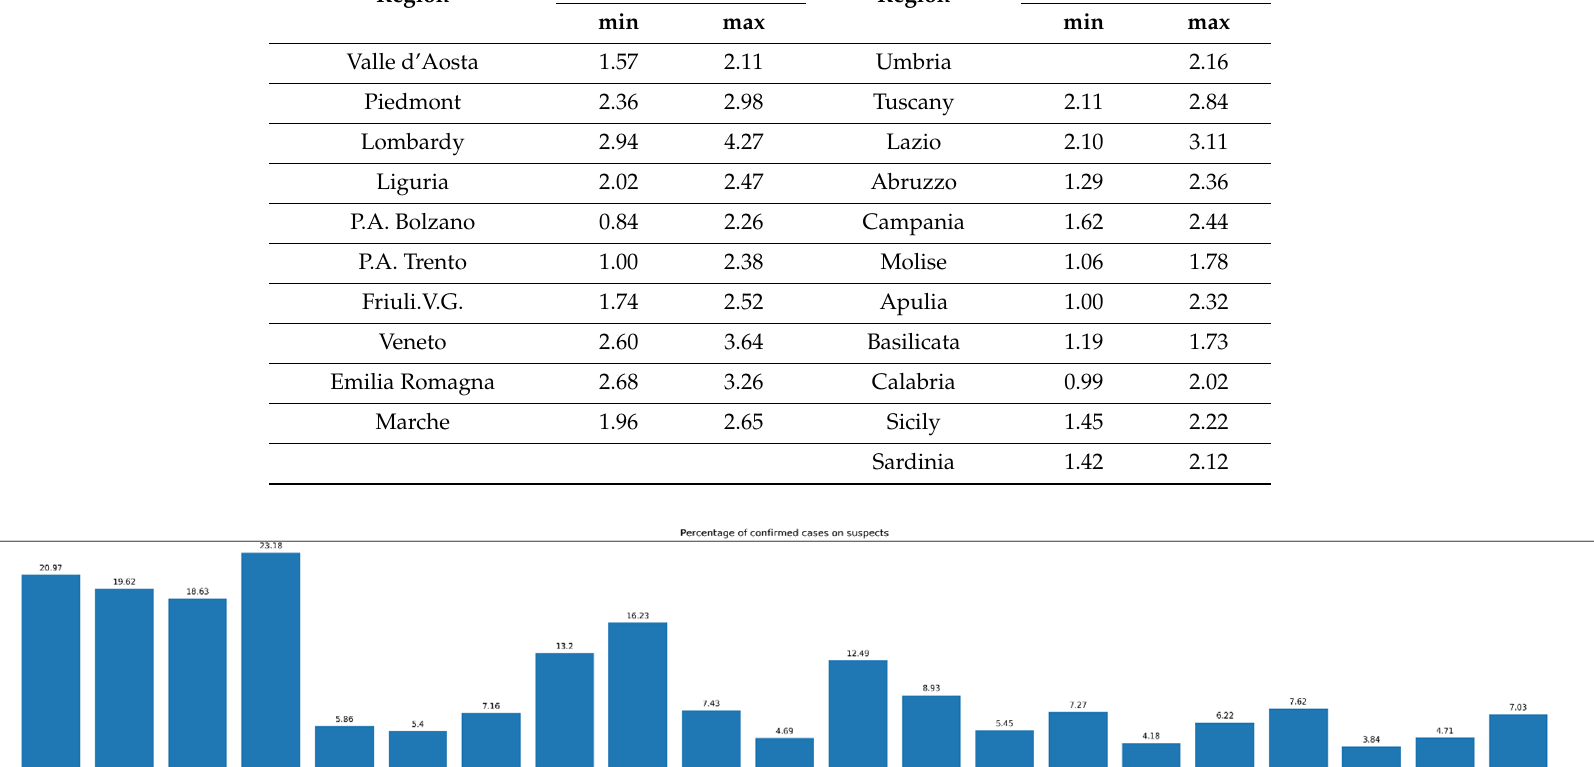
Table 1. Values of the analyzed regions. Given the trend, min values usually refer to the beginning of the infection.